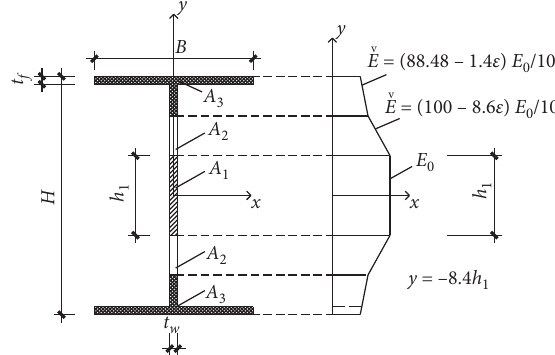
Figure 6: The percentage decline of elastic modulus in unloading stage.